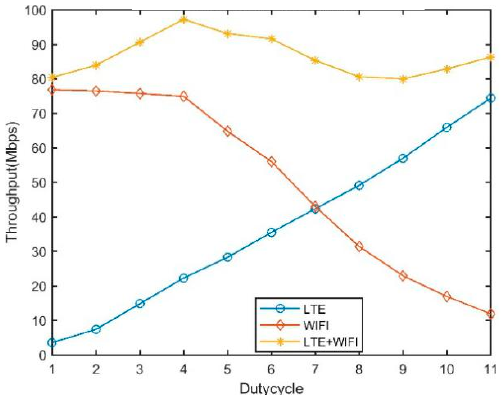
Figure 1. CableLabs experiment on LTE-U [7].